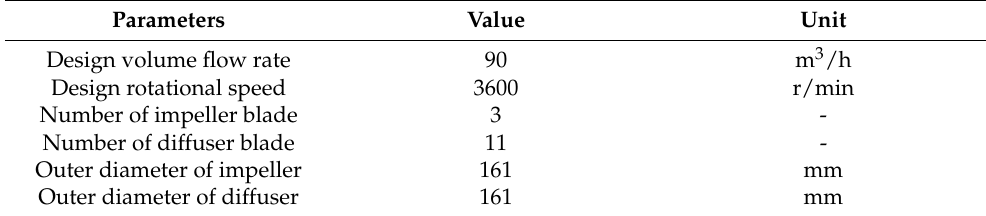
Table 1. Major parameters of the helico-axial